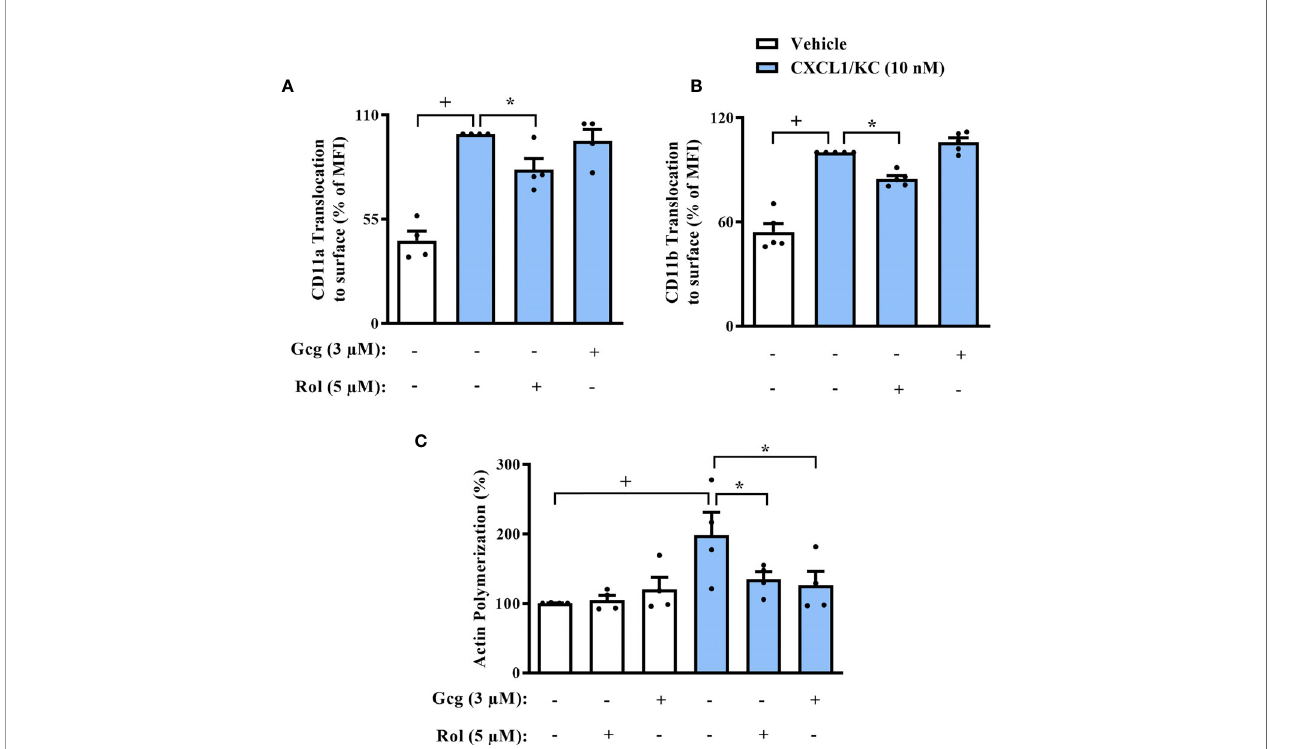
FIGURE 5 | Glucagon inhibits CXCL-1/KC-induced actin polymerization in mice neutrophils in vitro but does not alter CD11a nor CD11b translocation to surface. Cells were pre-treated 30 min with glucagon, rolipram or vehicle in vitro and then stimulated with CXCL1/KC (10 nM) or medium for 40 min in vitro . (A) CD11a and (B) CD11b translocation to neutrophils surface was represented as the percentage of MFI values that were obtained by FACS. Representative density plots of CD11a and CD11b expression on murine BM-neutrophils surface are reported in SM Figures S3 and S4 , respectively. (C) Actin polymerization was performed by immuno fl uorescence with TRITC-labeled phalloidin. Representative images of actin fi laments stained with TRITC-phalloidin are reported in SM Figure S5 . For (A, C) , BM-neutrophils from 4 random male mice were obtained. For (B) , BM-neutrophils from 5 random male mice were obtained. Each animal sample was equally distributed to all experimental groups. Sample results were obtained by blinded and randomized analysis. The vehicles used were DMSO 0.1% or medium to rolipram and glucagon, respectively. Each value represents the mean ± S.E.M. The statistical analysis was performed by one-way ANOVA followed by Newman – Keuls – Student ’ s t-test. Results are representative of one individual assay. + P < 0.05 compared to non-stimulated cells. * P < 0.05 compared to stimulated cells. Gcg, Glucagon;. Rol,